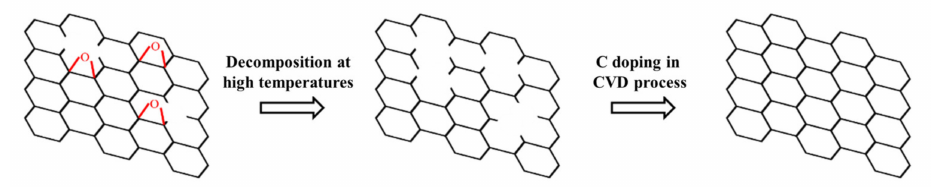
Figure 11. Schematic diagram of the repair process of BM introducing defect